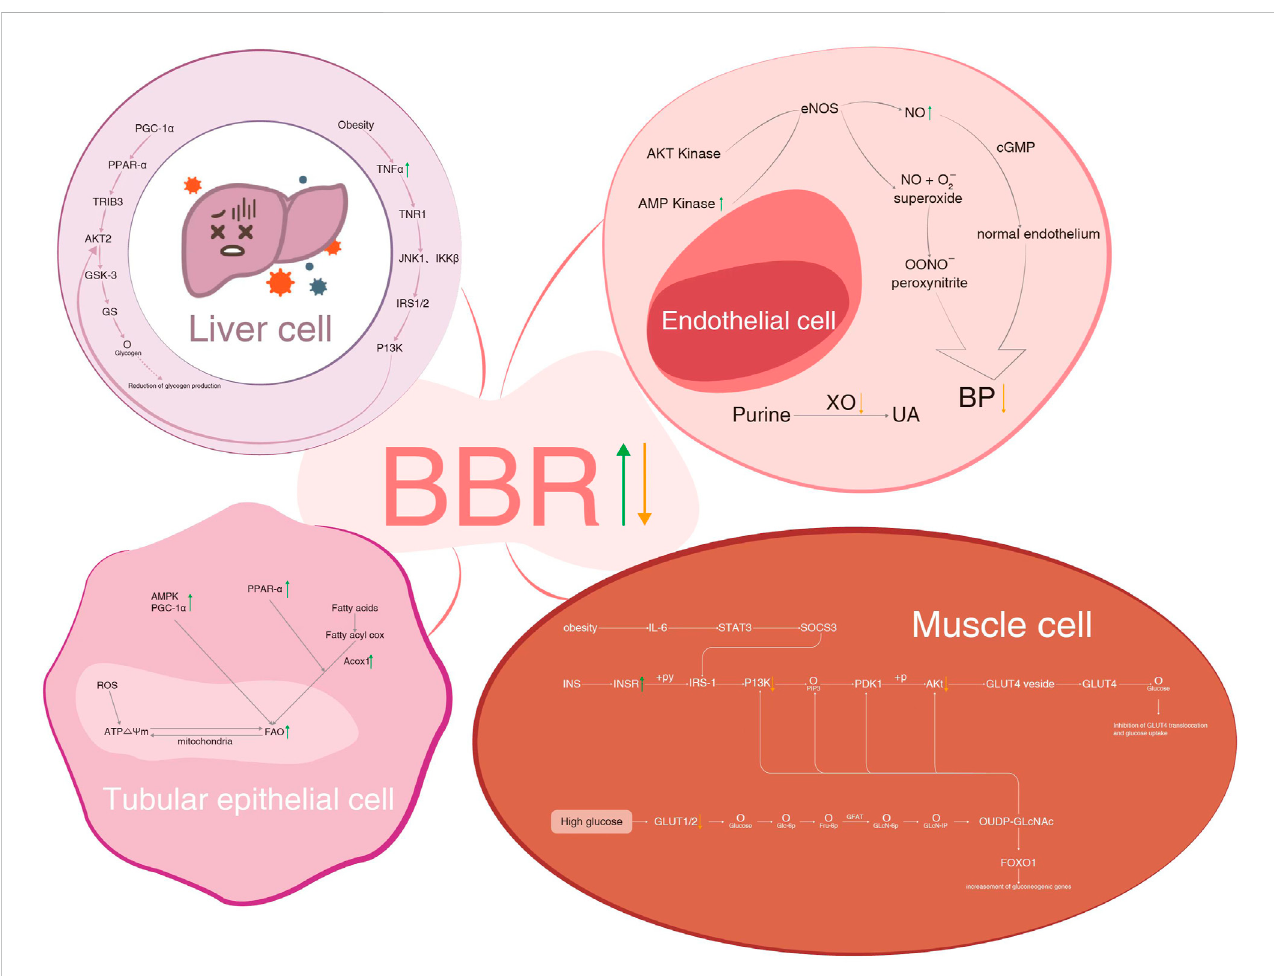
FIGURE 5 BBR on metabolic pathways of IR in liver cell and muscle cells, hypertension and hyperuricemia in endothelial cells, and hyperlipidemia in tubular epithelial cells. BBR, berberine; IR, insulin resistance; PGC-1 α , peroxisome proliferator-activated receptor- γ coactivator 1 α ; PPAR- α , peroxisome proliferator- activated receptor α ; GLUT4, glucose transporter 4; TR1B3, tribbles homologue 3; AKT2, RAC serine/threonine-protein kinase; GSK-3, glycogen synthase kinase-3; GS, glycogen synthase; TNF- α , tumor necrosis factor- α ; TNR1, tumor necrosis factor receptor 1; JNK1, c-Jun-N-terminal kinase 1; IKK β , inhibitor of nuclear factor kappa-B kinase subunit beta; IRS1/2, insulin receptor substrate 1/2; P13K, phosphatidylinositol-3-kinase; AMP, adenosine 5 ’ - monophosphate activated protein; cGMP, cyclic guanosine monophosphate; ROS, reactive oxygen species; Acox1, acyl-coenzyme a oxidase 1; IL-6, interleukin-6; STAT3, signal transducer and activator of transcription 3; SOCS3, suppressor of cytokine signaling 3; INS, insulin; INSR, insulin receptor; +py, tyrosine phosphorylation; PDK1, phosphoinositide-dependent kinase-1; GLUT4 vesicle, glucose transporter 4 vesicle; GFAT, glutamine fructose phosphate transaminase; FOXO1, forkhead box